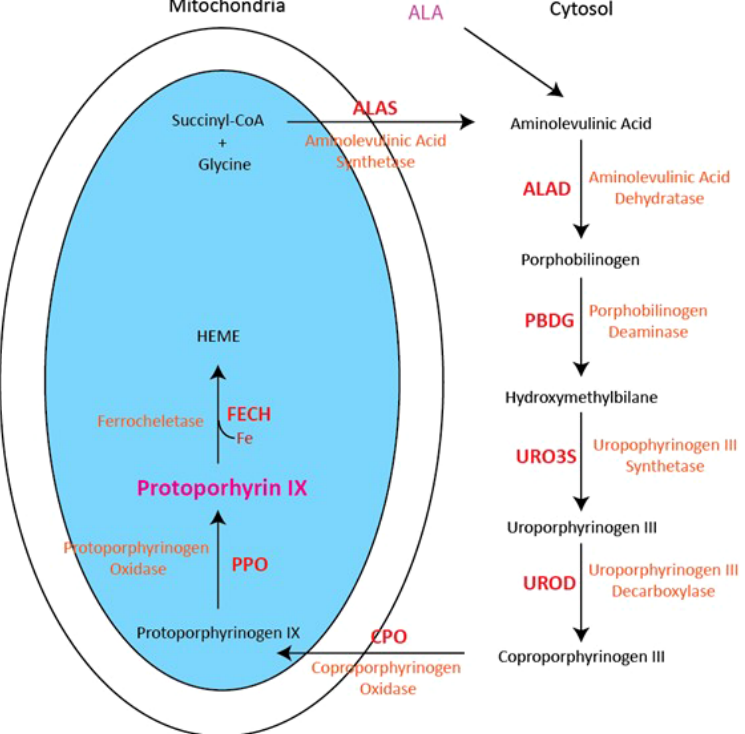
Fig. 2. Overview of the Heme Biosynthesis Pathway. The Heme Biosynthesis pathway is present in most mammalian cells with the rate-determining enzyme being ALAS (or the synthesis of aminolevulinic acid), thus ALA induced PpIX bypasses the rate-limiting step through use of exogenous ALA. Also note that in tumor cells there is a de¯ciency of Ferrochelatase or a reduction in the amount of free iron in the cells leading to a build-up of protoporphyrin IX